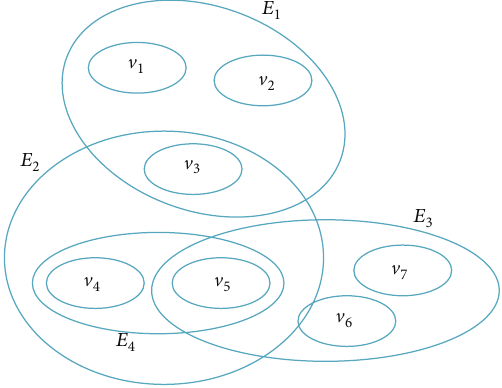
Figure 1: An example of hypergraph.